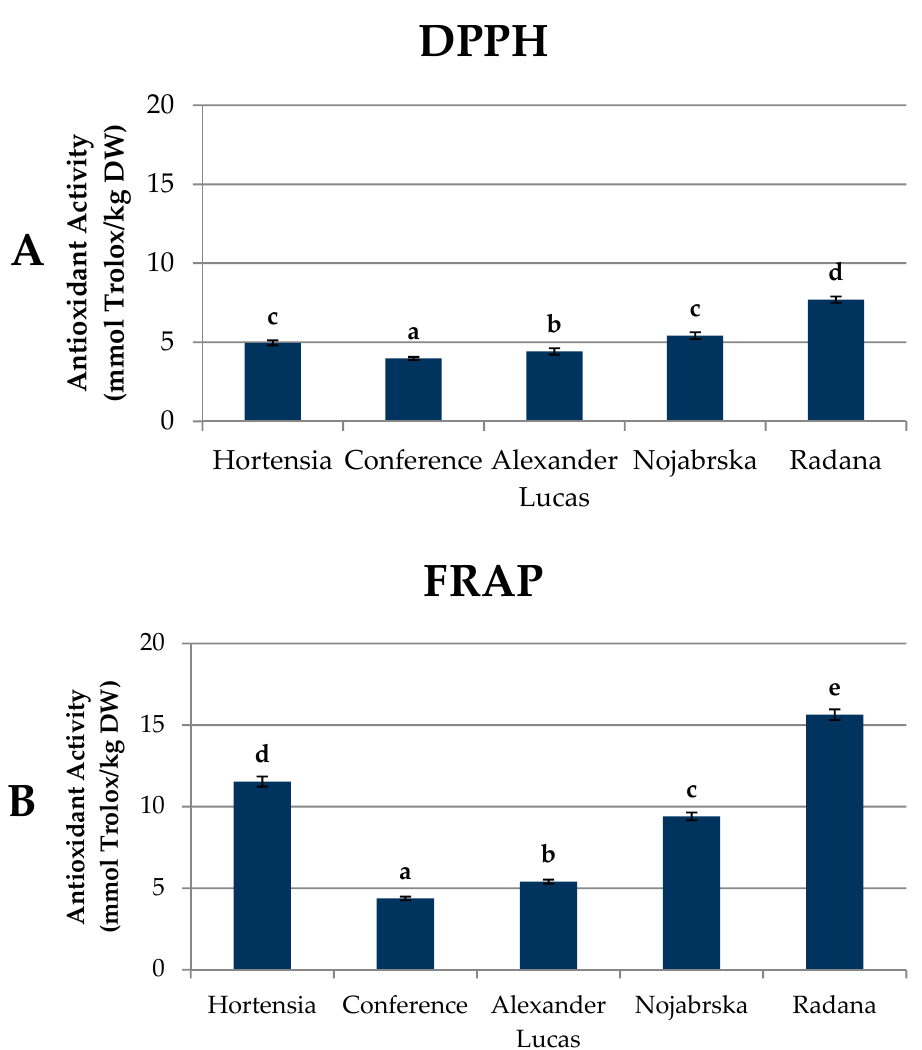
Figure 5. Antioxidant activity of pear fruits (mmol Trolox/kg DW) measured as ( A ) the free radical scavenging activity (DPPH method) and ( B ) ferric reducing capacity using the ferric ‐ reducing ability of plasma (FRAP) method. Varieties with different letters were significantly different at p = 0.05 according to Duncan’s test. The data are expressed as mean ± SD ( n = 9). FRAP: ferric ‐ reducing ability of plasma.